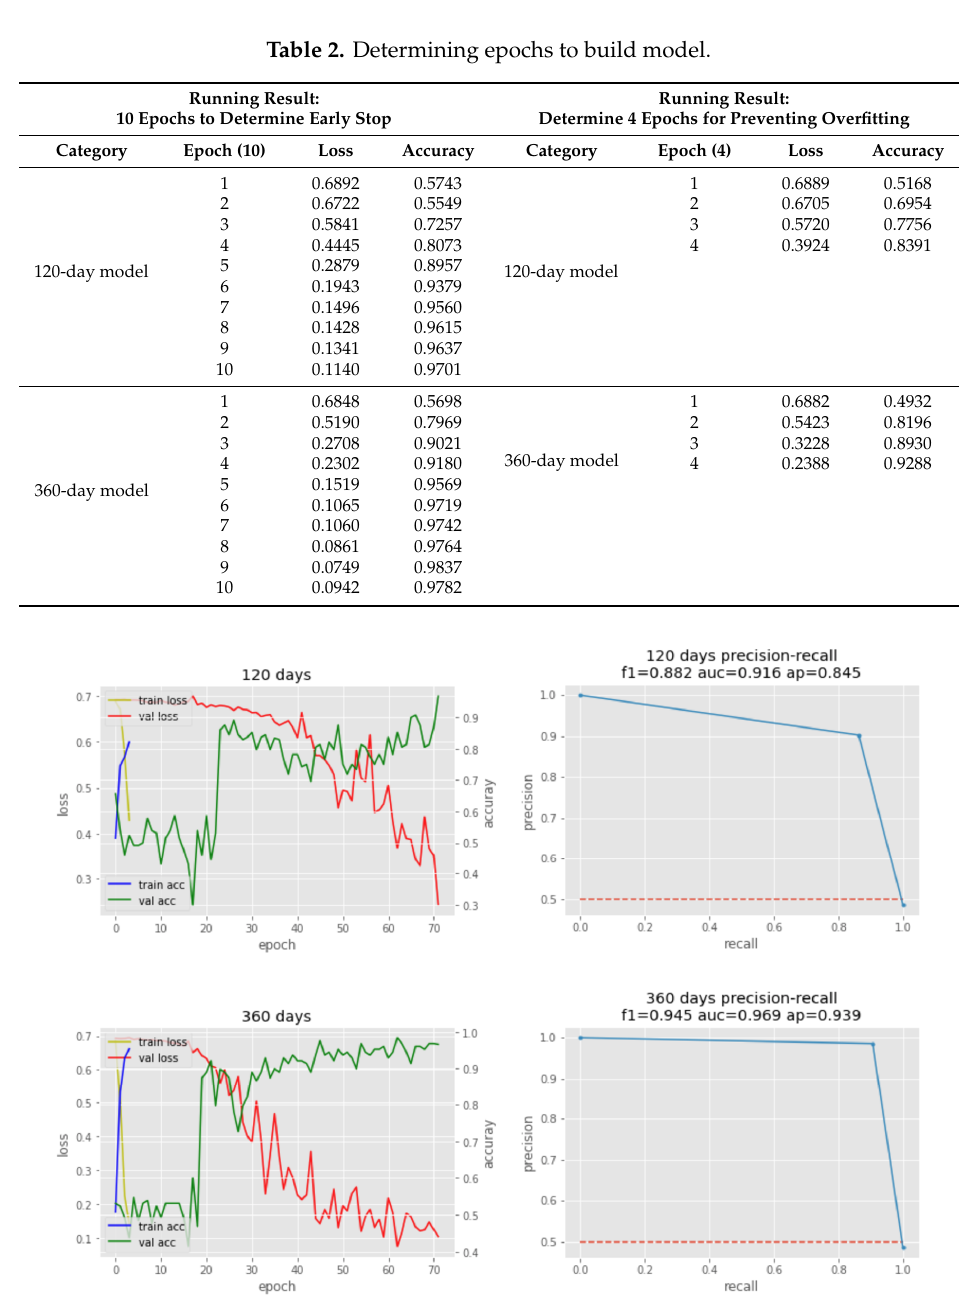
Figure 6. Phased LSTM training / validation (left) and precision-recall plots (right).